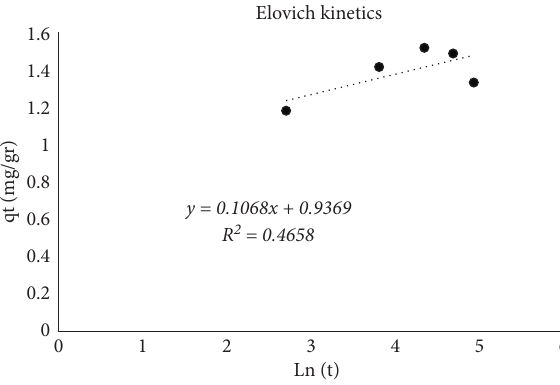
Figure 16: Zero-order kinetics for TT powder. Table 7: Adsorption kinetic constants for MG powder.